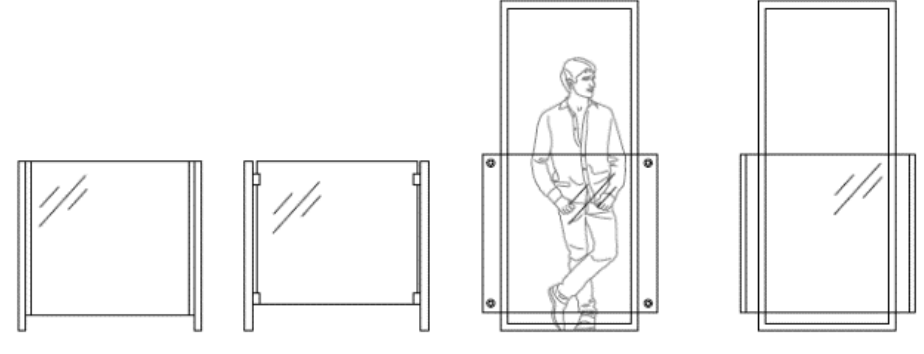
Fig. 1 Barriers classified as Class